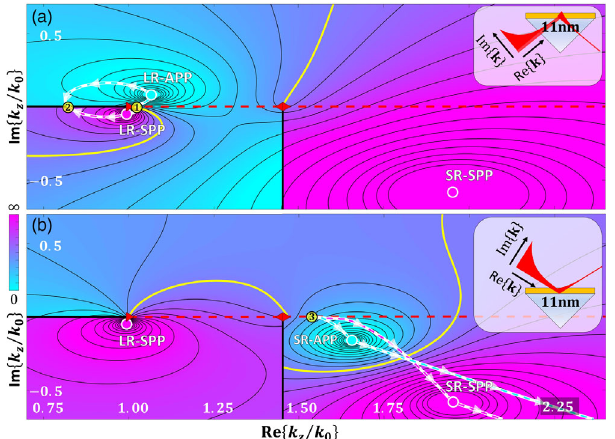
FIG. 8. Dependence of APPs on the direction of illumination. The field amplitude reflection coefficient r of an 11 mn gold film at illumination wavelength λ ¼ 800 nm calculated over the complex wave-vector range k z observable when illuminating from (a) the glass prism side and (b) the air side. SPPs and APPs correspond to exact reflection pole (magenta) and zero (cyan) wave vectors (white circles), respectively. Unlike SPPs, the supported APPs depend on the illumination direction: In (a), a “ long-range ” APP is paired to the long-range SPP, and in (b), a different “ short-range ” APP is paired to the short-range SPP (white curves denote their calculated root locus as the film thickness decreases from ∞ → 0 ). The reflection coefficient is calculated in the topological neighborhood of the real wave- vector axis for illumination with wave vectors exceeding the light line in air (left dashed red line) and glass (right dashed red line), with branch cuts denoted by black lines. The j r j ¼ 1 contour line is colored